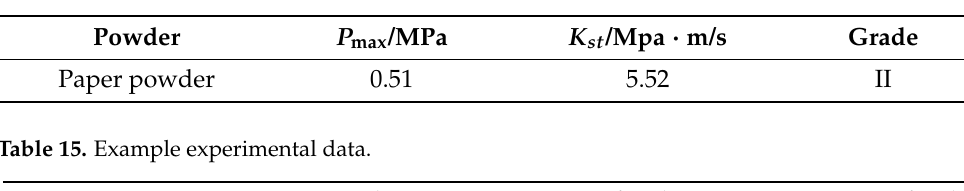
Table 14. Experimental data on dust explosion severity.